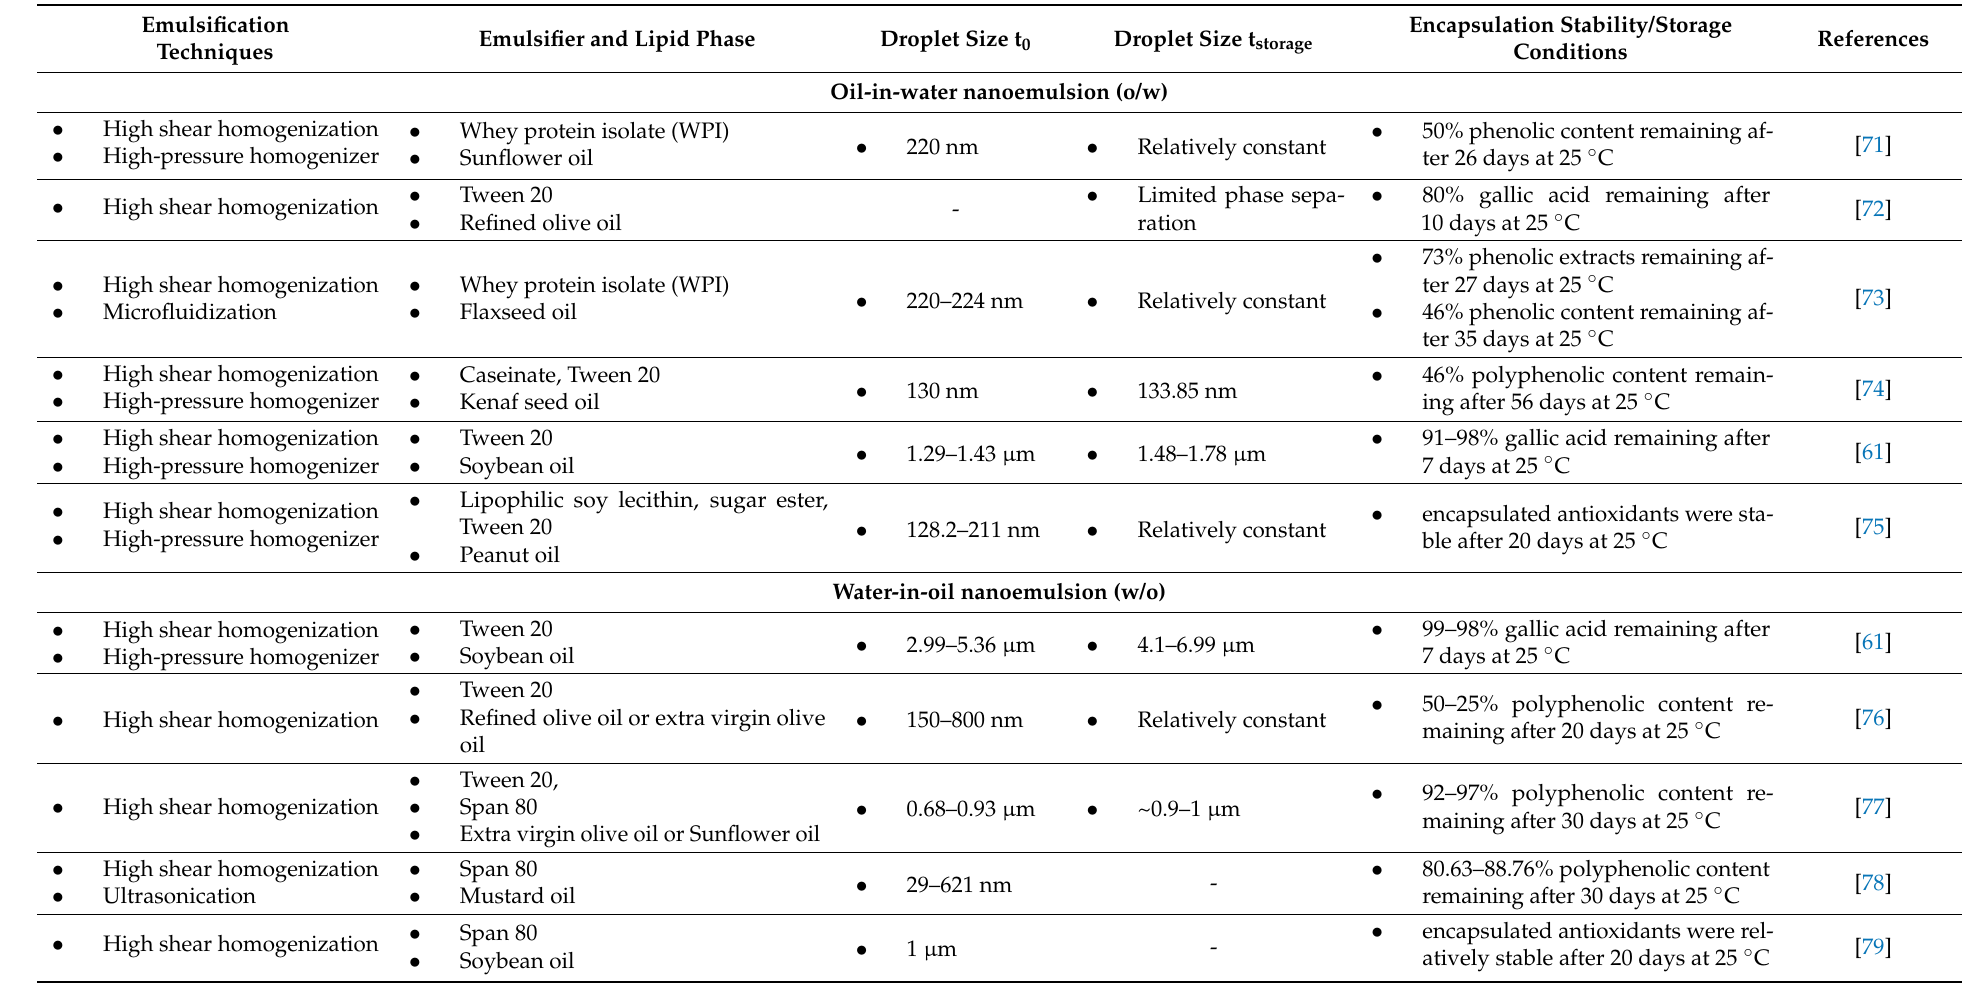
Table 4. Emulsion and nanoemulsion delivery systems for polyphenols reported in the